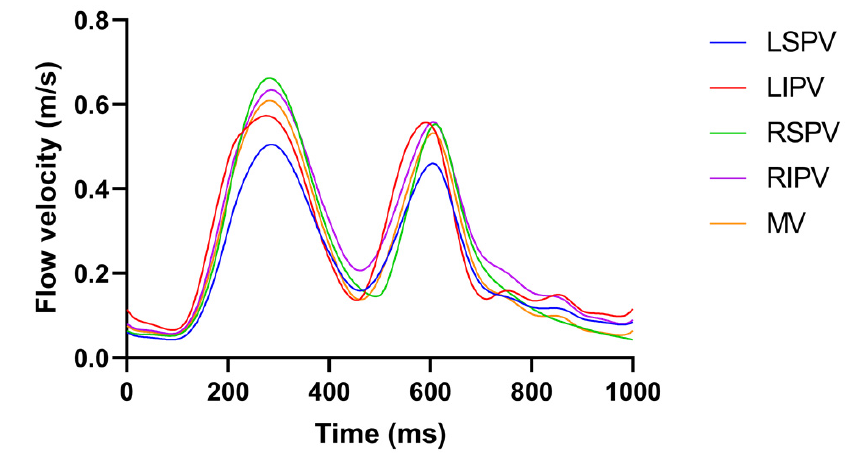
Figure 2. The pulsatile blood flow profiles at the four PVs and MV in the LA model.